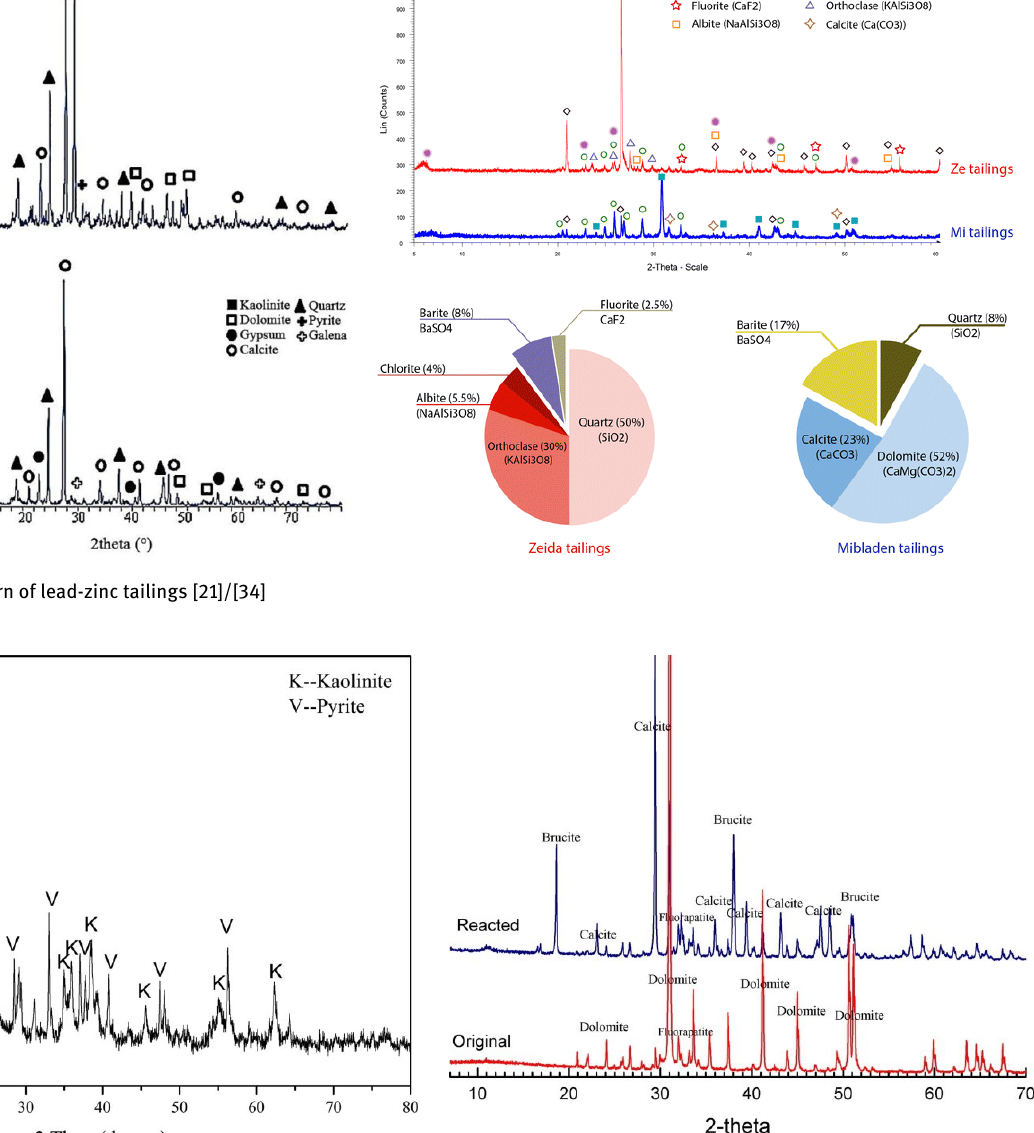
Figure 3: XRD pattern of pyrite tailings [35] are more and more “silt” and “clay” in the tailings, and even if tailings are used as aggregate, the maximum size of tailings is less than 1 mm in some literature [34, 36]. In general, the tailings have a highly rough and irregular sur- face [28], since the grindability of various mineral phases in the tailings is different. Due to the mineral phases, the tailings have a varied density and water absorption, which is also remarkably affected by the particle size as shown in Figure 5.